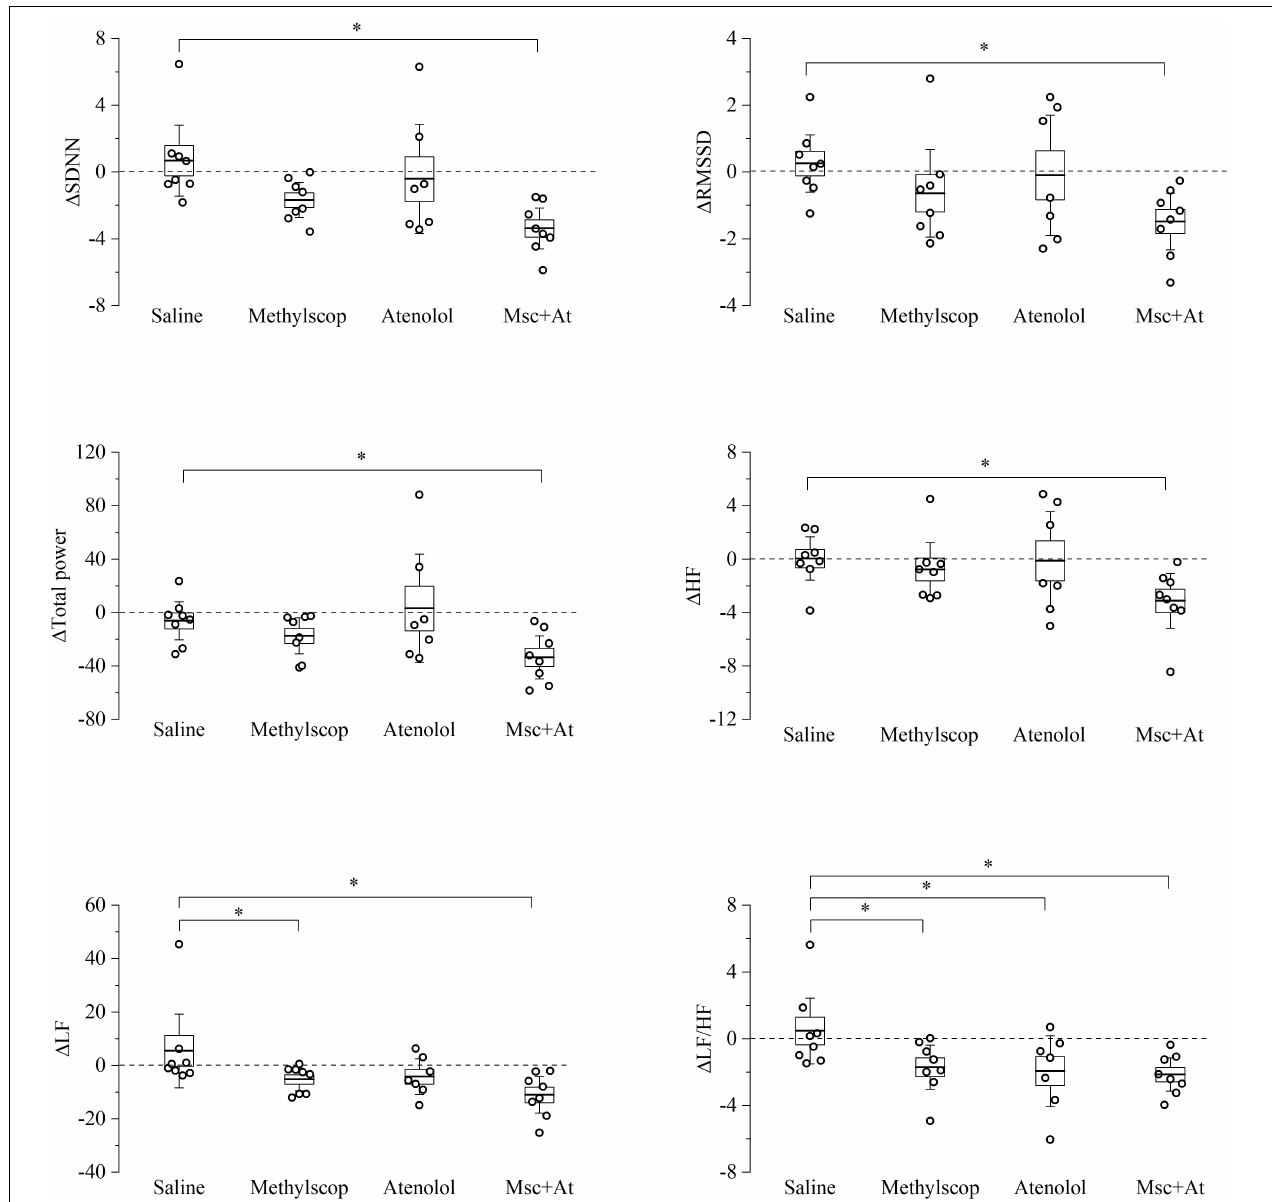
FIGURE 4 | Heart rate variability parameters response to pharmacological autonomic blockade in 19-month-old mice. Changes in the heart rate variability parameters calculated from ECG traces recorded from 60 to 120 min after i.p. injection of vehicle (saline) and autonomic modulator drugs (Methylscopolamine, Atenolol, Methylscopolamine + Atenolol) in 19-month-old freely moving mice ( n = 9). The dotted line (reference level) indicates mean basal HRV indexes recorded 60 min before drug administration. In the box chart, middle line indicates the mean value, delimiting lines of the box represent SEM and whiskers are confidence intervals at 95%. ∗ p < 0.05, one-way ANOVA with repeated measures followed by Fisher’s LSD post hoc